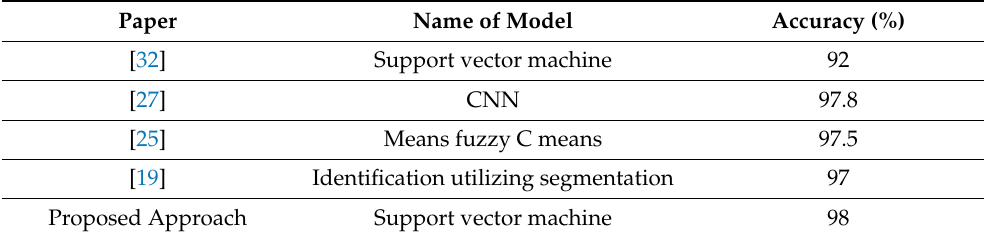
Table 6. Comparison with state-of-the-art